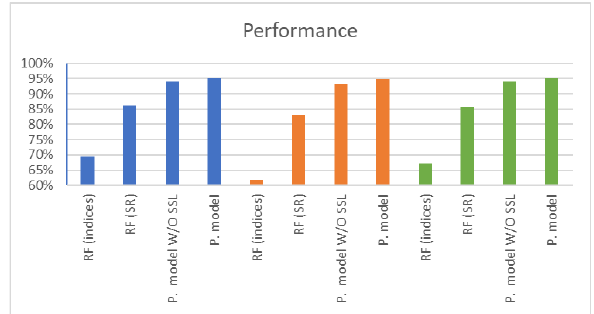
Figure 8. The performance Comparison under temporal and spatial variance. The blue, orange and green colors represent F1-Micro, F1-Macro and F1-Weighted respectively.